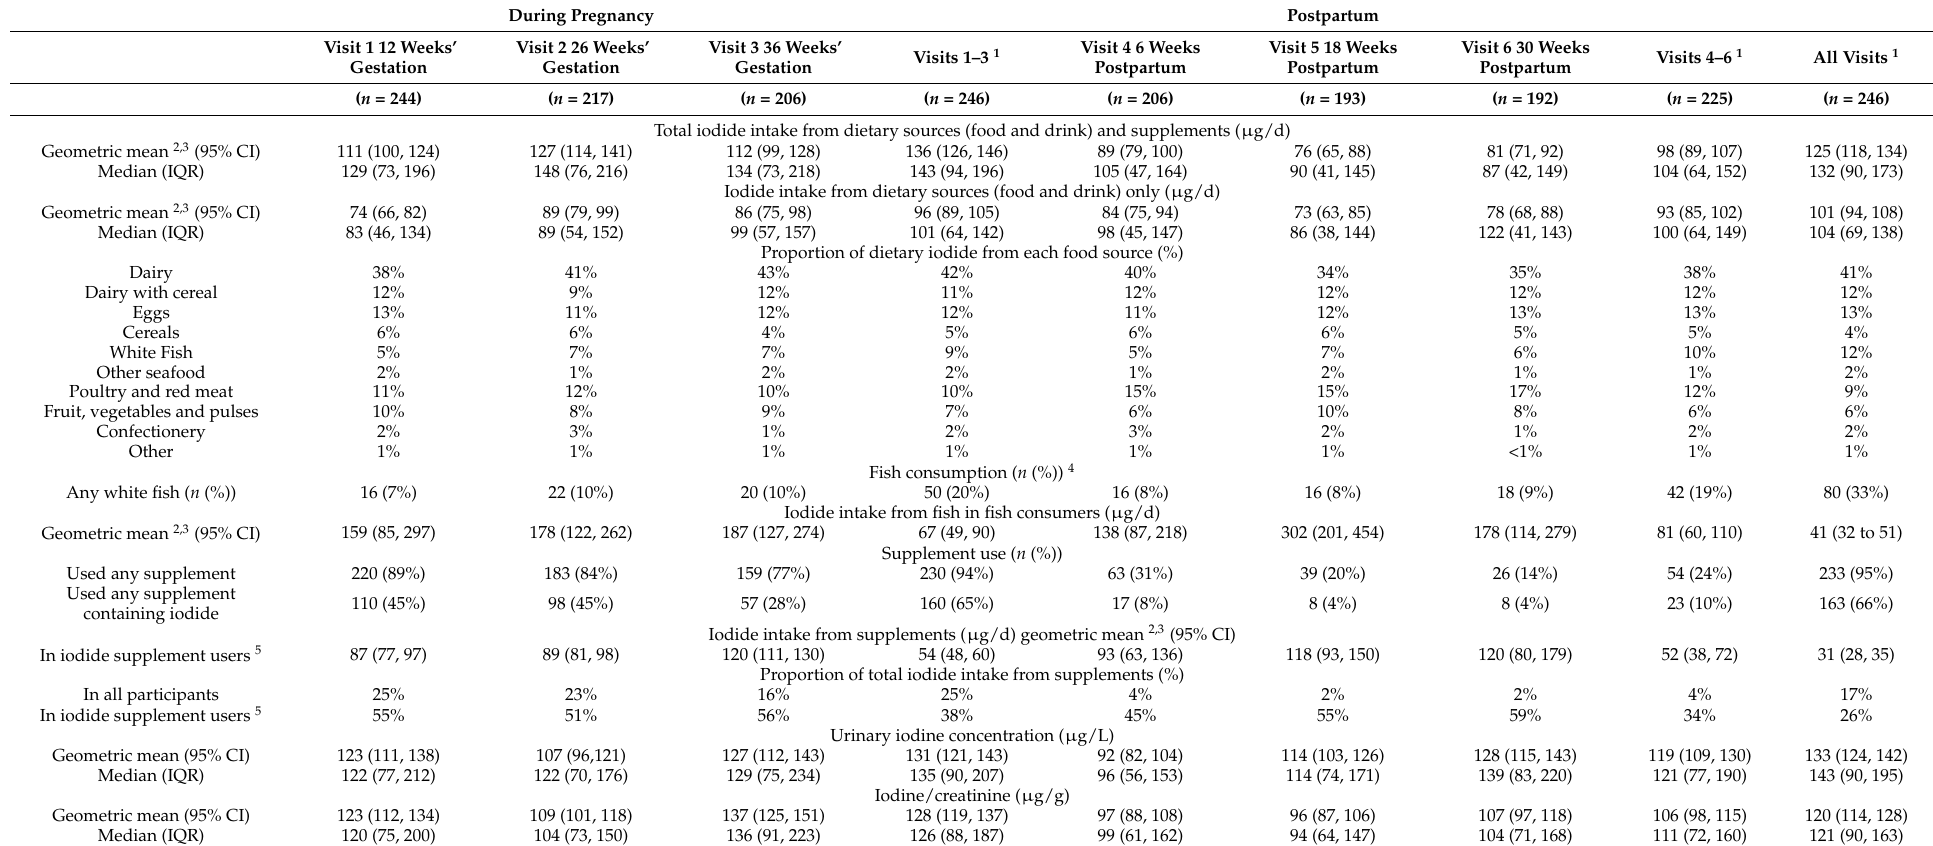
Table 2. Total iodide intake, sources of iodide intake, supplemental iodide use and urinary iodine status by study visit. During